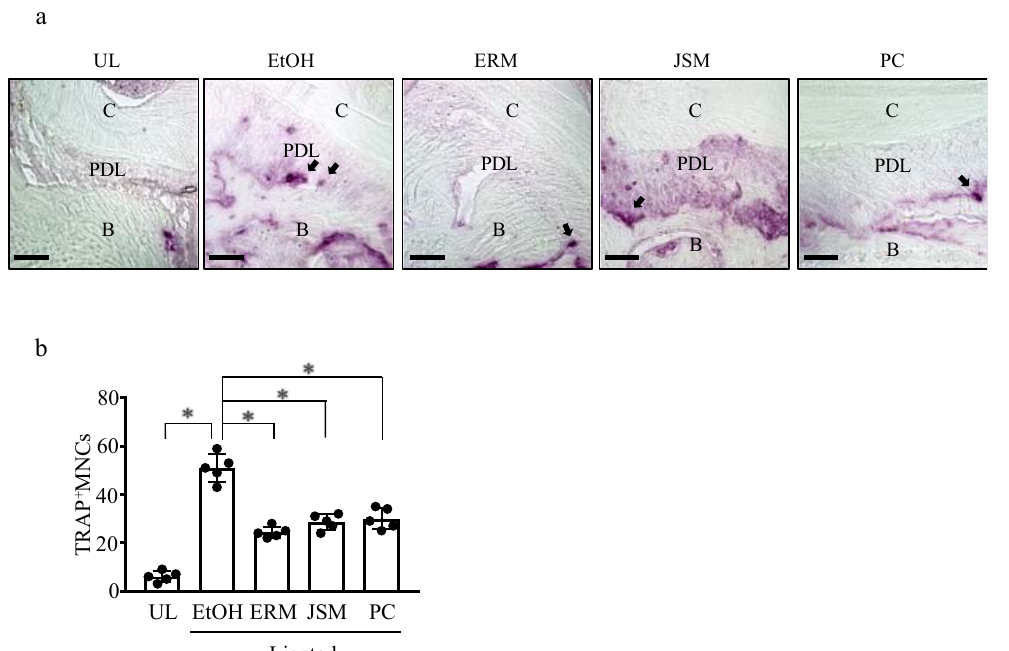
Figure 3. Erythromycin inhibits ligature-induced osteoclast differentiation. ( a , b ) Frozen maxillae sections were stained with tartrate-resistant acid phosphatase (TRAP). ( a ) Representative images obtained by optical microscopy are shown; arrows indicate TRAP + osteoclasts. C: cementum; PDL: periodontal ligament; B: alveolar bone. ( b ) TRAP-reactive multinucleated cells (MNCs) were counted in five coronal sections of ligated sites of each mouse. Scale bars, 50 µm. * p < 0.05 compared to ligated + ethanol (EtOH) group, means ± SD ( n = 5 per group).